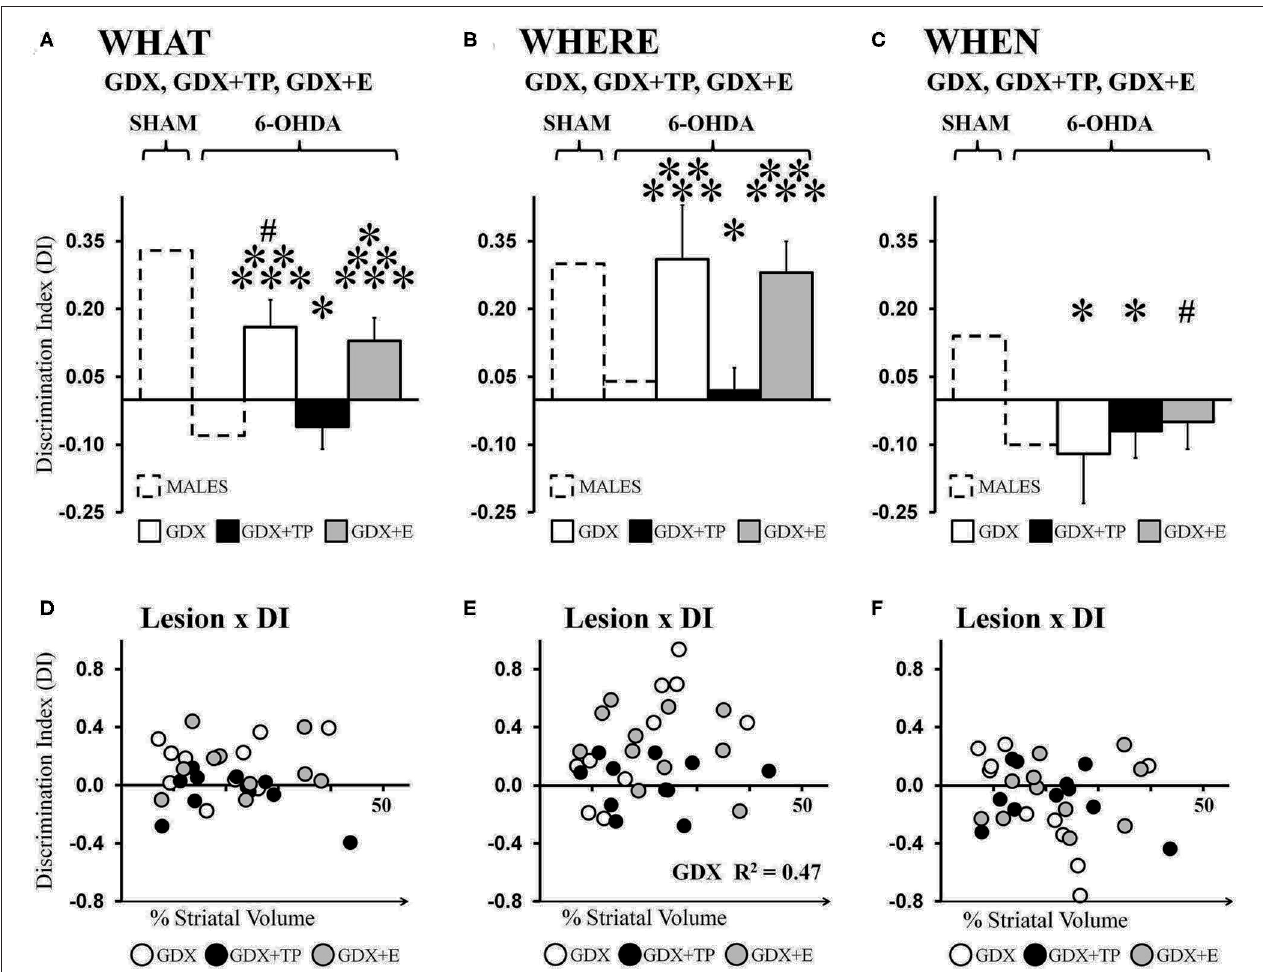
FIGURE 5 | Bar graphs showing average “What” (A) , “Where” (B) , and “When” (C) discrimination indices (DIs) calculated from object exploration in Test Trials for 6-hydroxydopamine (6-OHDA) lesioned male rats that were gonadectomized (GDX, white), that were GDX and supplemented with testosterone propionate (black), or GDX and supplemented with 17 β -estradiol 6-OHDA (gray); data from gonadally intact SHAM and 6-OHDA lesioned MALES are shown for reference (dashed outline). The GDX + TP cohort was profoundly impaired for “What” (A) , “Where” (B) , and “When” (C) discriminations. In contrast, DI’s for the GDX and GDX + E groups were moderate for “What,” robust for “Where,” and poor for “When.” Results from allowed post-hoc comparisons of DI that included all of the male groups are shown as follows: significantly different than MALE SHAM (*); near significantly different than MALE SHAM (#); significantly different than MALE 6-OHDA (**); significantly different than GDX + TP 6-OHDA groups (***).Scatter plots below of “What” (D) , “Where” (E) , and “When” (F) DIs as functions of the size (percent of total striatal volume) of 6-OHDA lesions for individual GDX (white circles), GDX + TP (black circles), and GDX + E (gray circles) 6-OHDA rats show no consistent relationships between the two for “What” or “When” DI. For “Where” DI, a significant positive correlation was found between larger lesions and better “Where” DI for GDX 6-OHDA rats; the R 2 -value is shown on the plot (E)